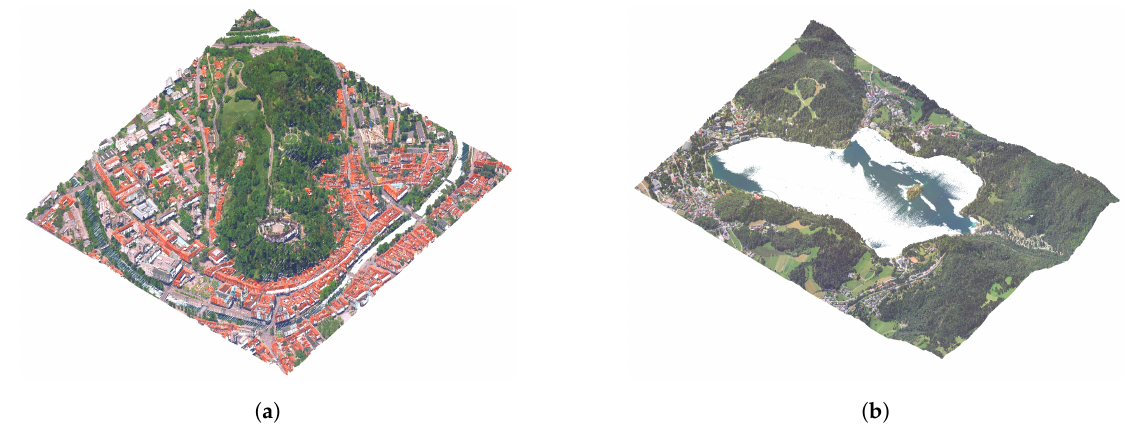
Figure 3. Examples of missing points on water surfaces: ( a ) rivers and ( b )